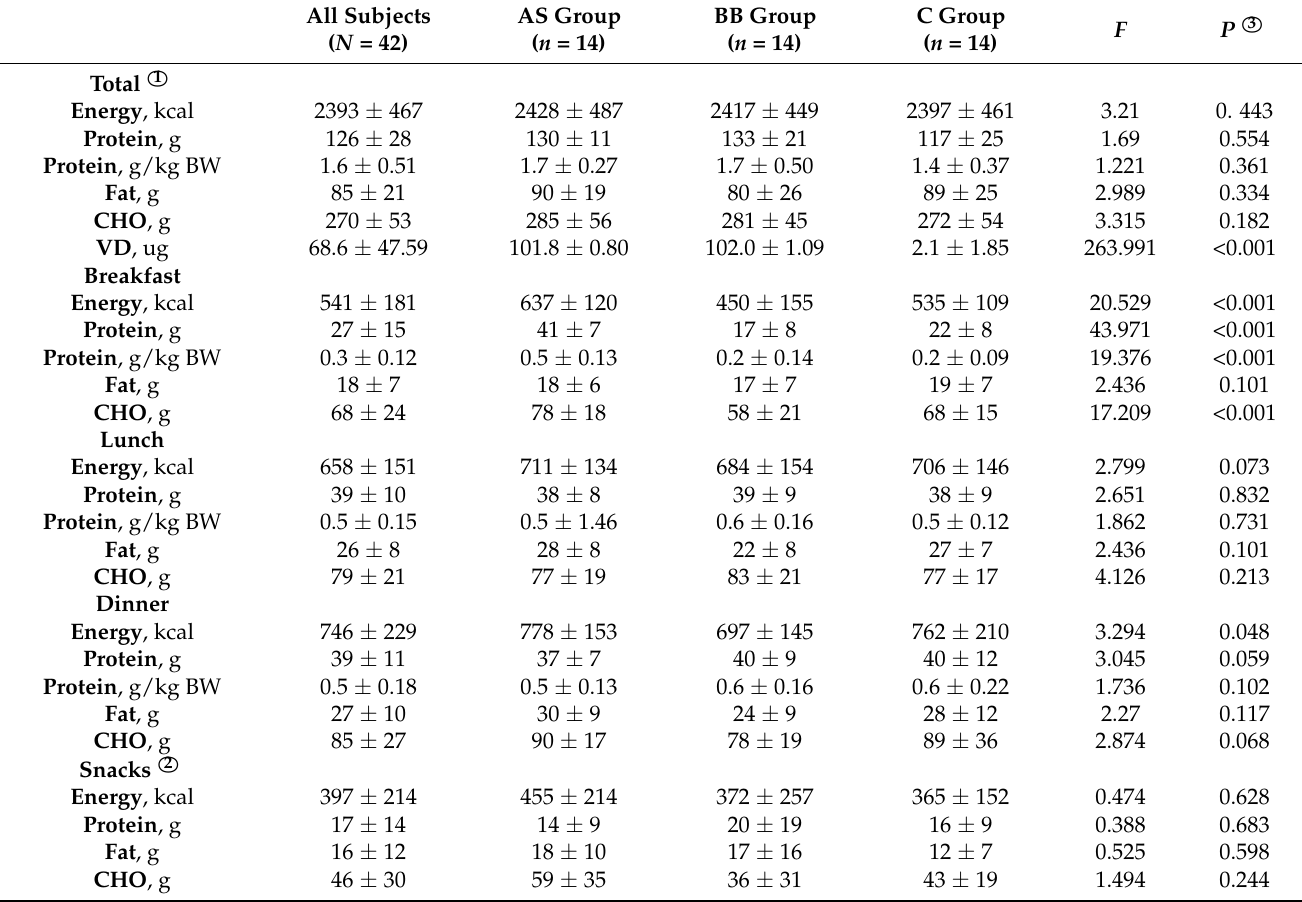
Table 3. Total dietary intake and dietary intake at each meal during